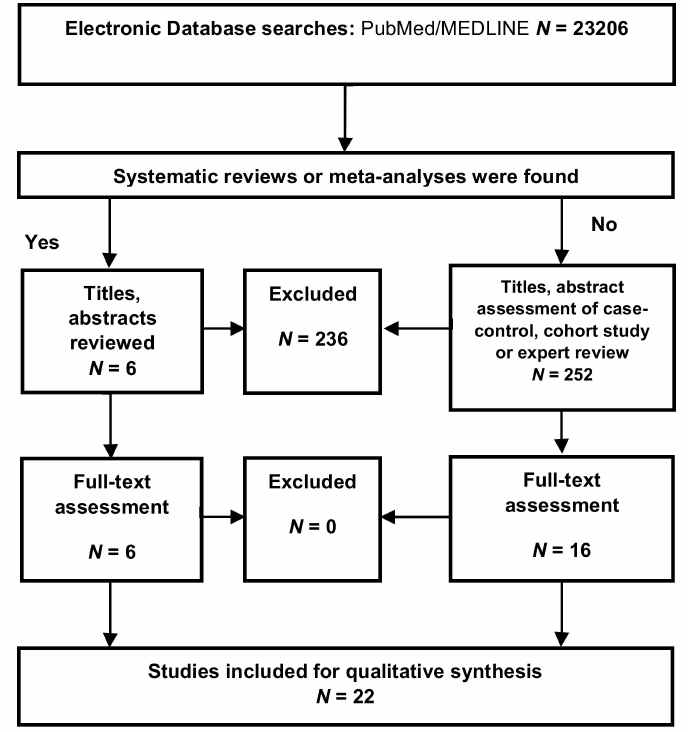
FigureA1. Flowdiagramofqualitativesynthesisregardinginflammatorycytokinesinneurodegenerative diseases, adopted from Preferred Reporting Items for Systematic Reviews and Meta-Analyses (PRISMA).